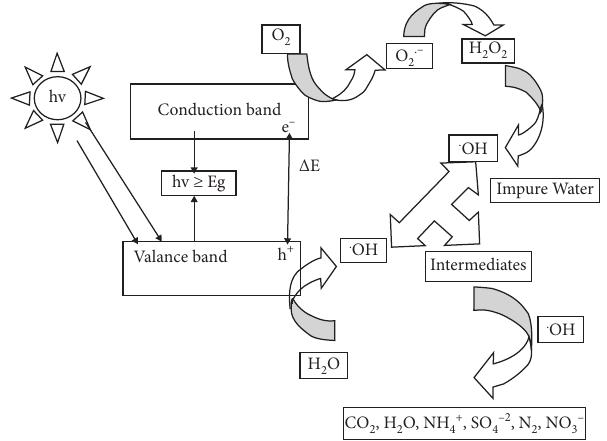
Figure 11: Basic principles of photocatalysis [95].